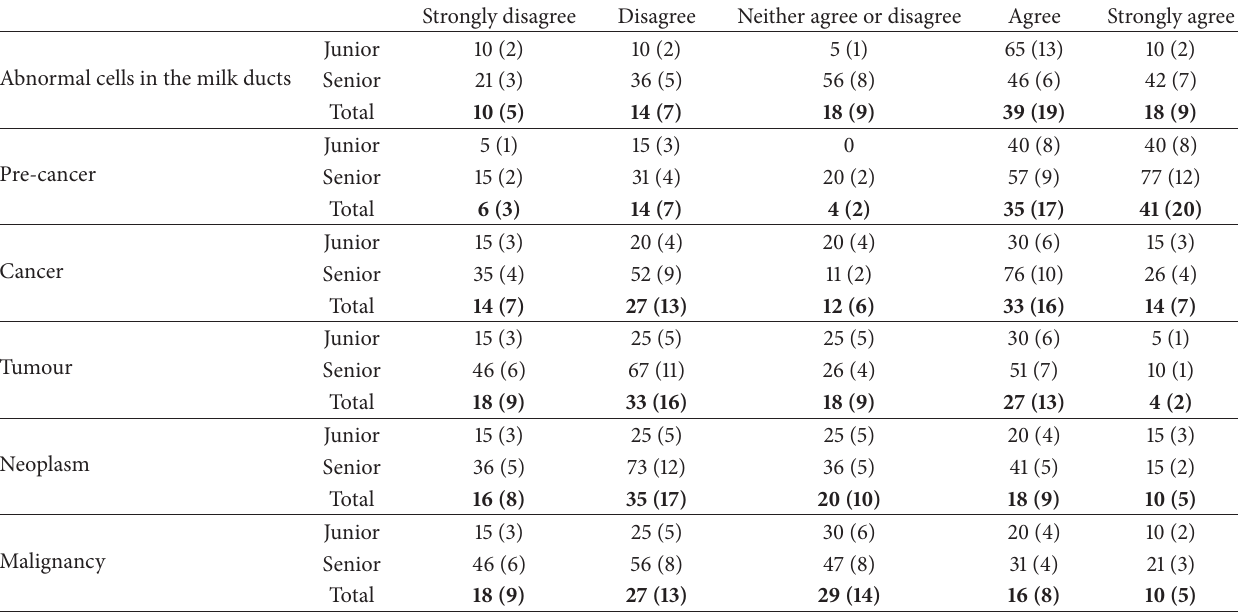
Table 2: Seniority and terminology (percentage in each group ( 𝑛 )).